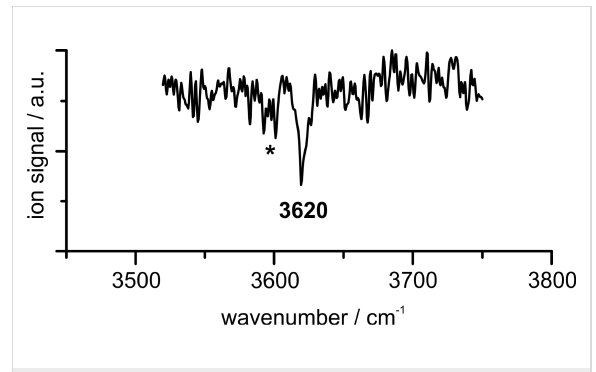
Figure 4: The IR/R2PI spectrum in the range of 3520–3750 cm − 1 was obtained via the excitation energy of 36885 cm − 1 using the carrier gas neon; the asterisk (*) indicates ionization-induced fragmentation from larger clusters (cf . Figure S2 in Supporting Information File 1).